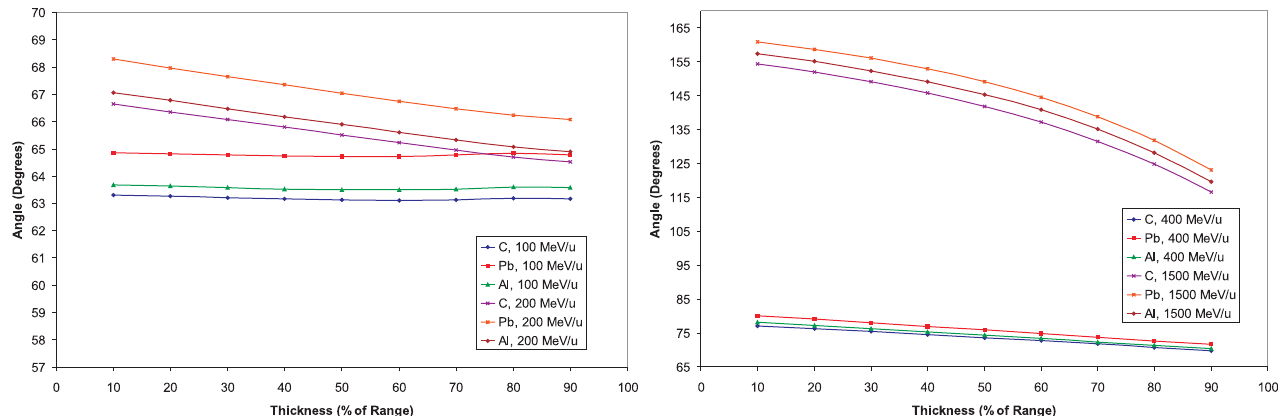
FIG. 15. (Color) Separation cut angles at different energies of a 132 Sn beam as a function of wedge material and thickness.